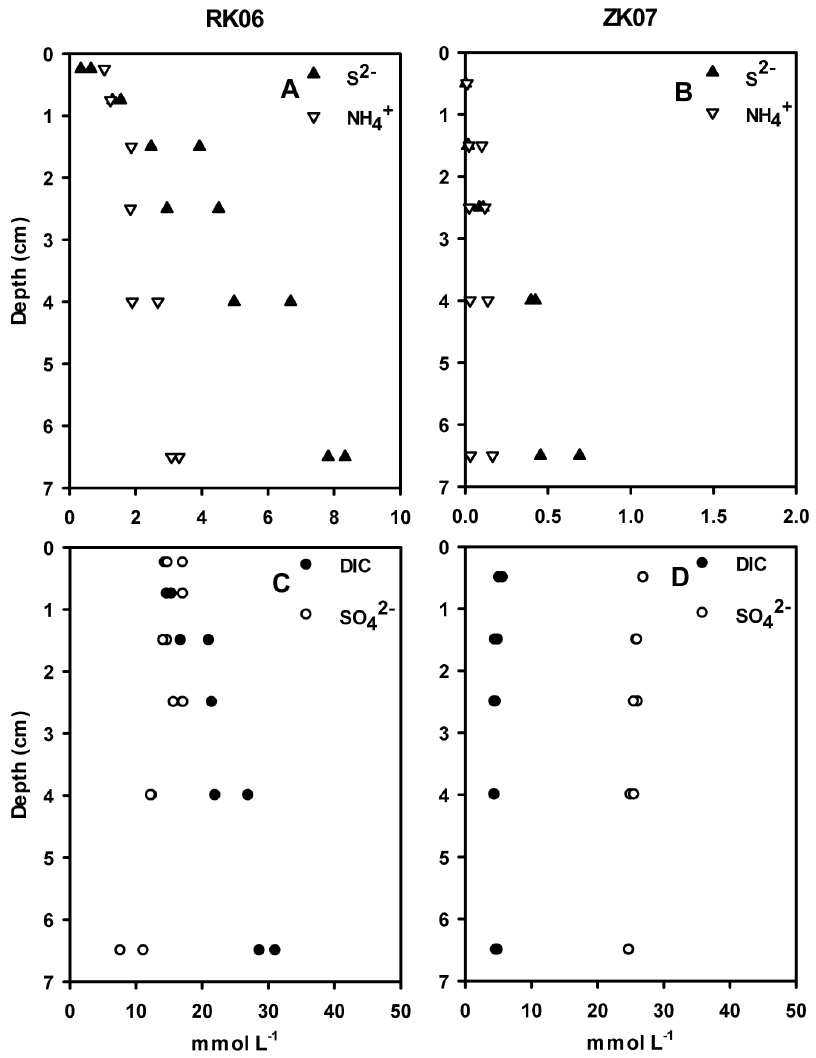
Figure 1. Porewater concentrations for the RK06 and ZK07 sediments. Shown are data for sulfide and ammonium (A, B) and for sulfate and DIC (C,